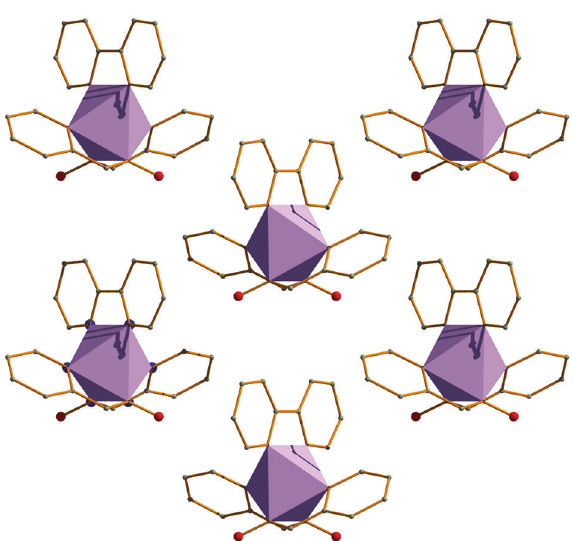
Figure 5: Packing diagram of complex 2 · 1.5MeOH along the c axis. The metal coordination spheres are polyhedron designed